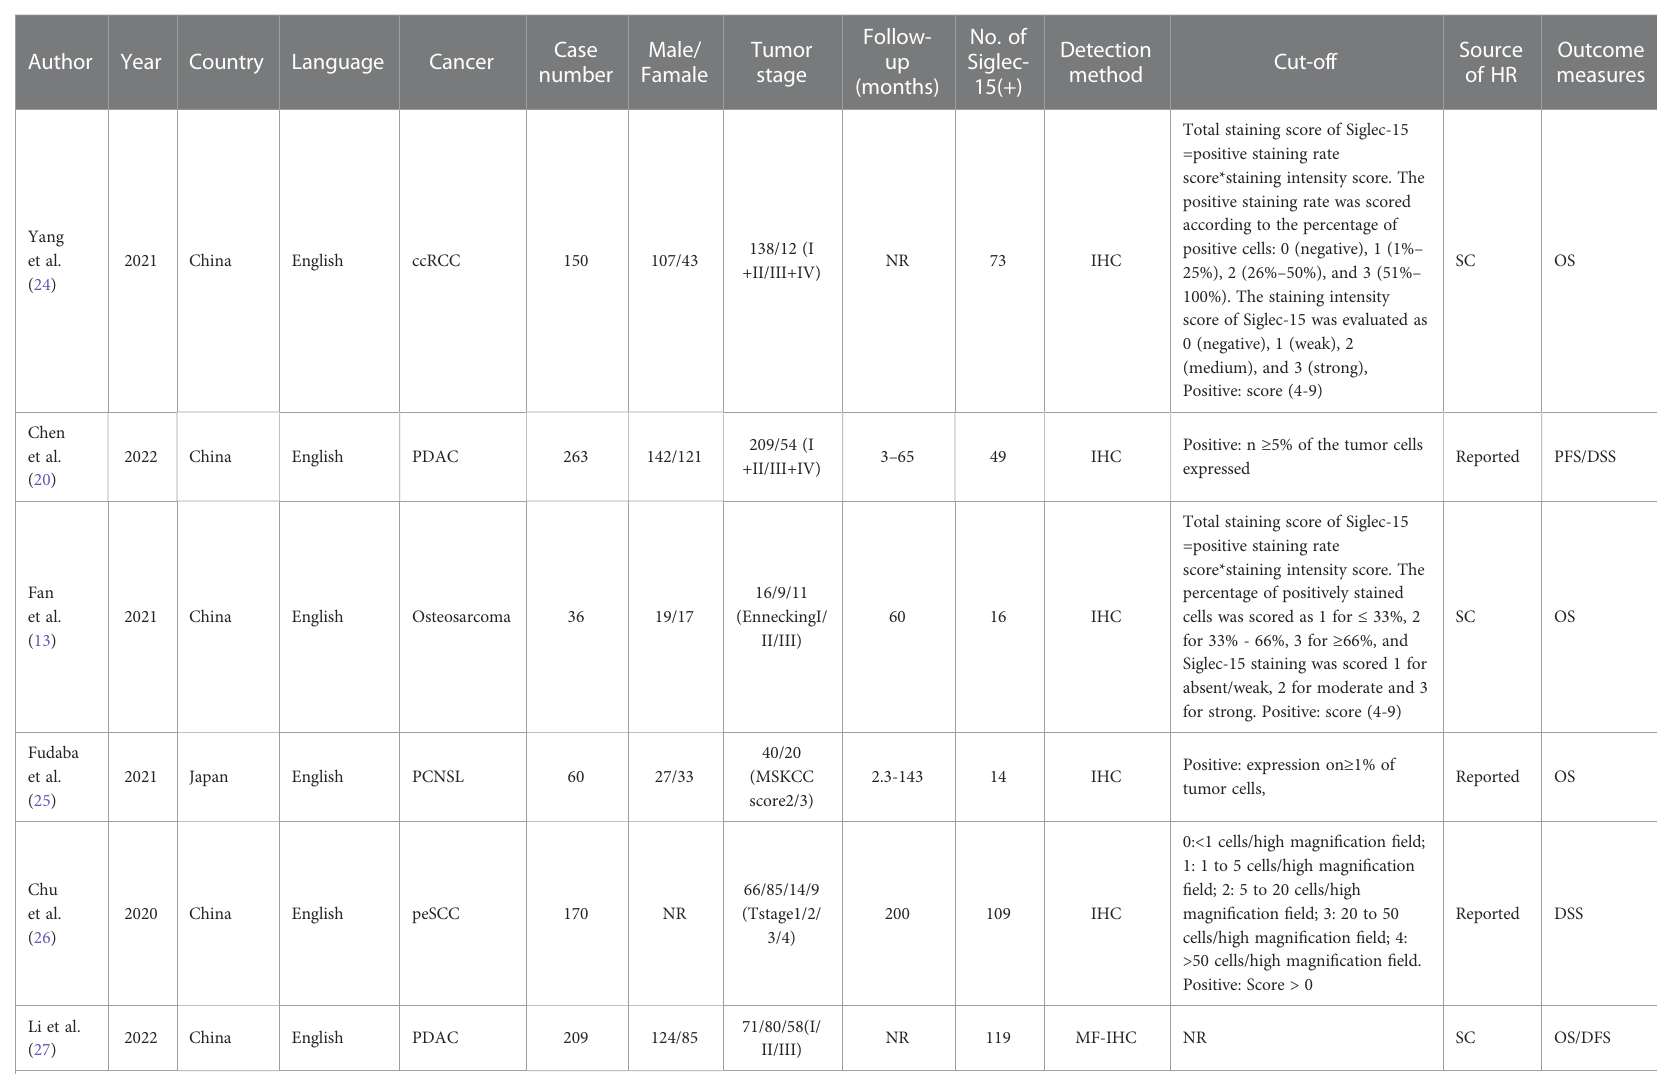
TABLE 1 Summary of characteristics of all studies included in the